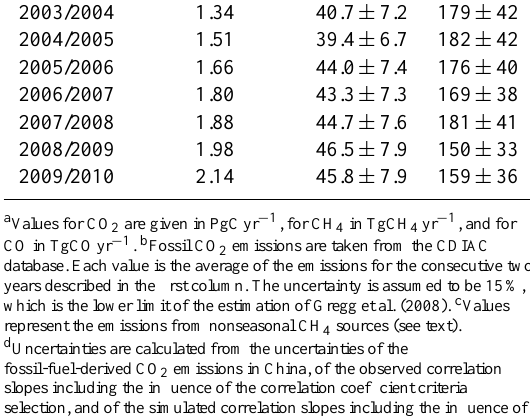
Fig. 9 (Tohjima et al.)